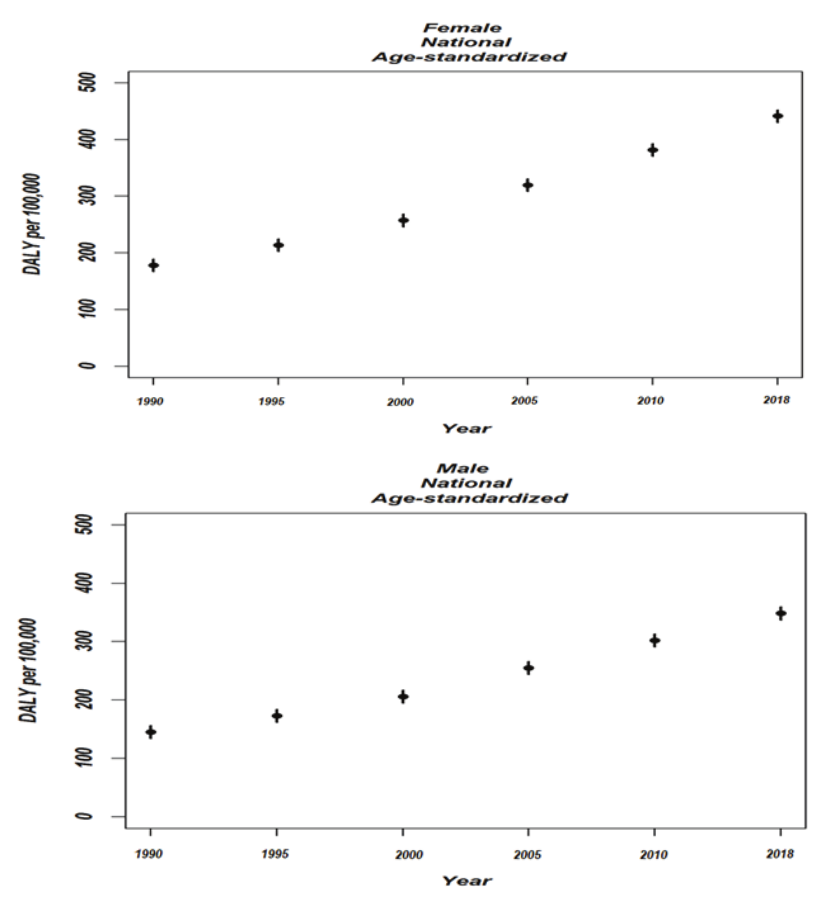
Figure 5. Age-adjusted DALYs (YLDs) per 100,000 at national level by sex from 1990 to